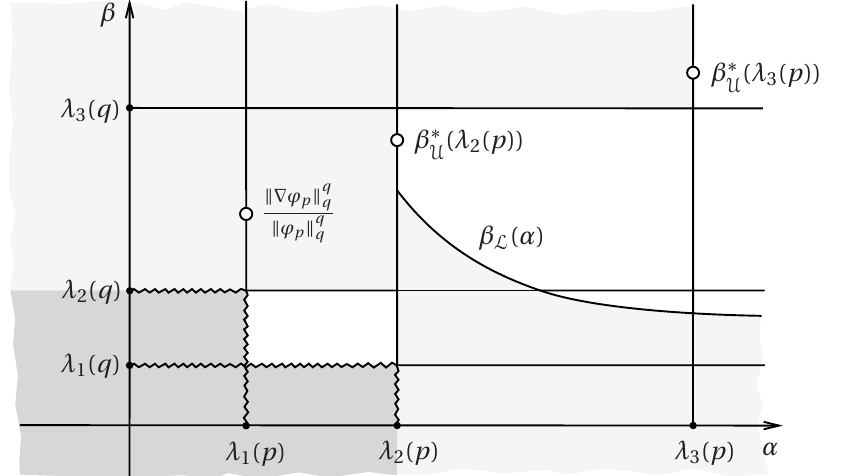
Figure 1: The case λ 2 ( q ) < λ 3 ( q ) , λ 2 ( p ) < λ 3 ( p ) , and ( λ 2 ( p ) , λ 3 ( p )) ∩ σ (− ∆ p ) = 0 . Existence (light gray, solid lines), nonexistence (dark gray, zigzag lines), unknown (white, dashed